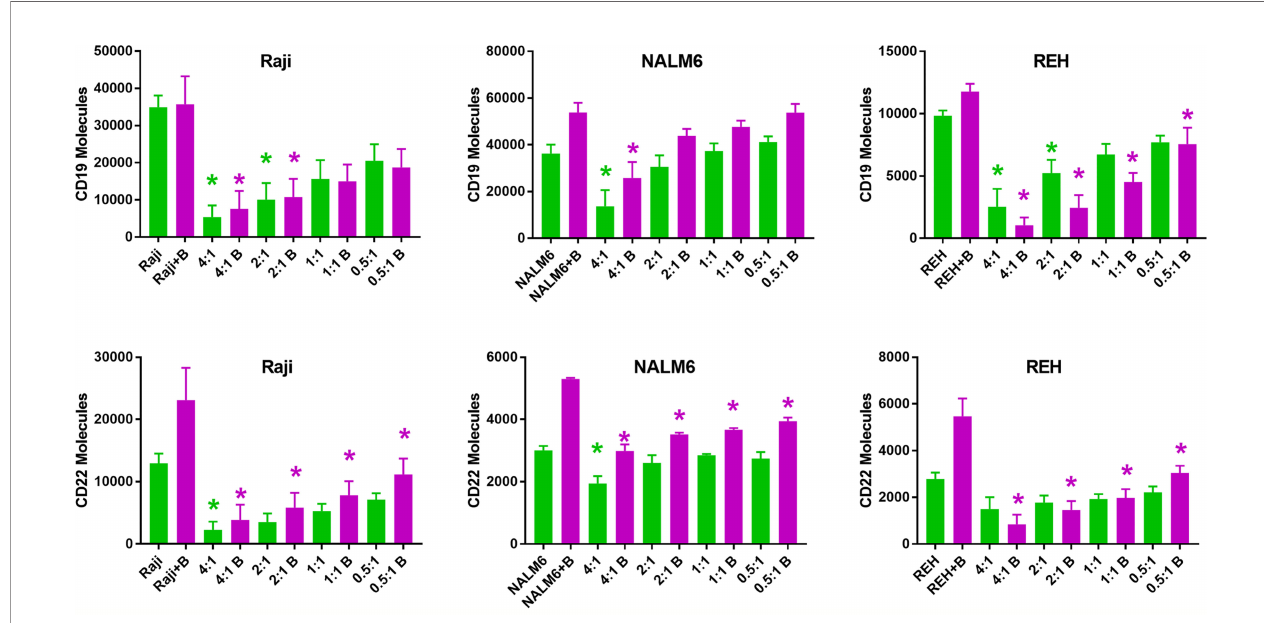
FIGURE 3 | Surface expression of CD19 and CD22 upon co-culture with anti-CD22 CAR-T. Using Quanti-Brite analysis, the number of CD19 and CD22 molecules (y-axis) on the surface of Raji, NALM6, and REH cell lines was quanti fi ed, following co-culture with CD22 CAR-T, at the indicated effector to target ratios, x-axis. The leftmost pair of columns quanti fi es surface expression on untreated cell lines. Signi fi cant differences from control are shown *p < 0.05. The x-axis lists the cell line tested, exposure to bryostatin (B, magenta bars) or CD22 CAR-T alone (green).